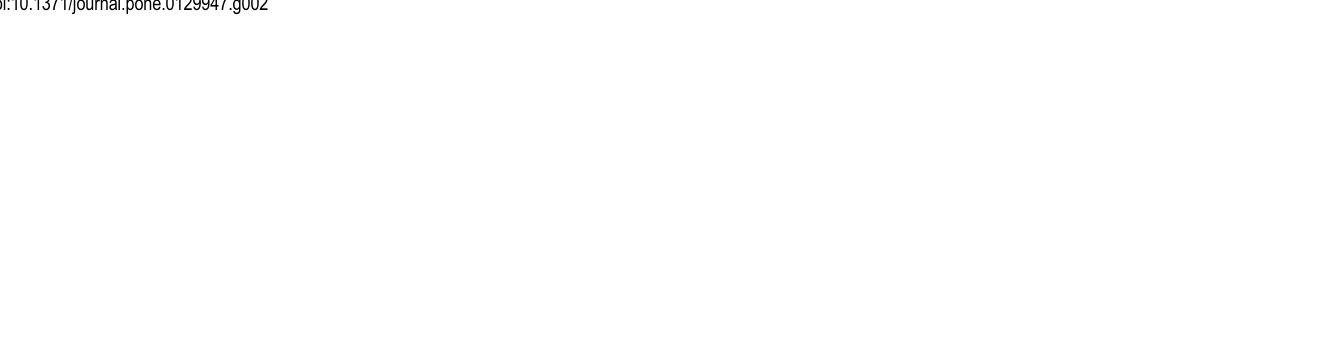
PLOS ONE | DOI:10.1371/journal.pone.0129947 June 26,